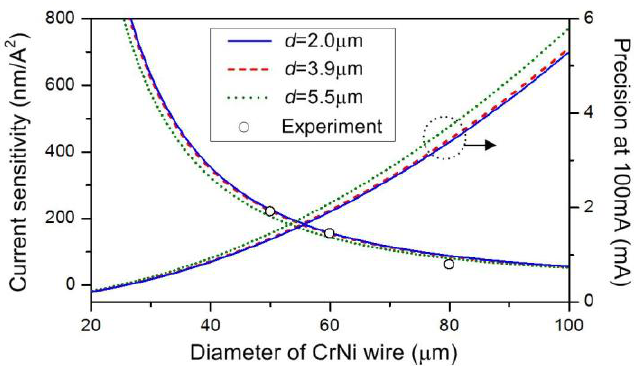
Figure 4. Current sensitivities as functions of the CrNi diameter, corresponding to the microfiber sizes of d = 2.0, 3.9, and 5.5 μm, respectively. The curves are the calculated values and the points are our experimental results. A precision at 100 mA is achieved considering a 0.06 nm resolution of the